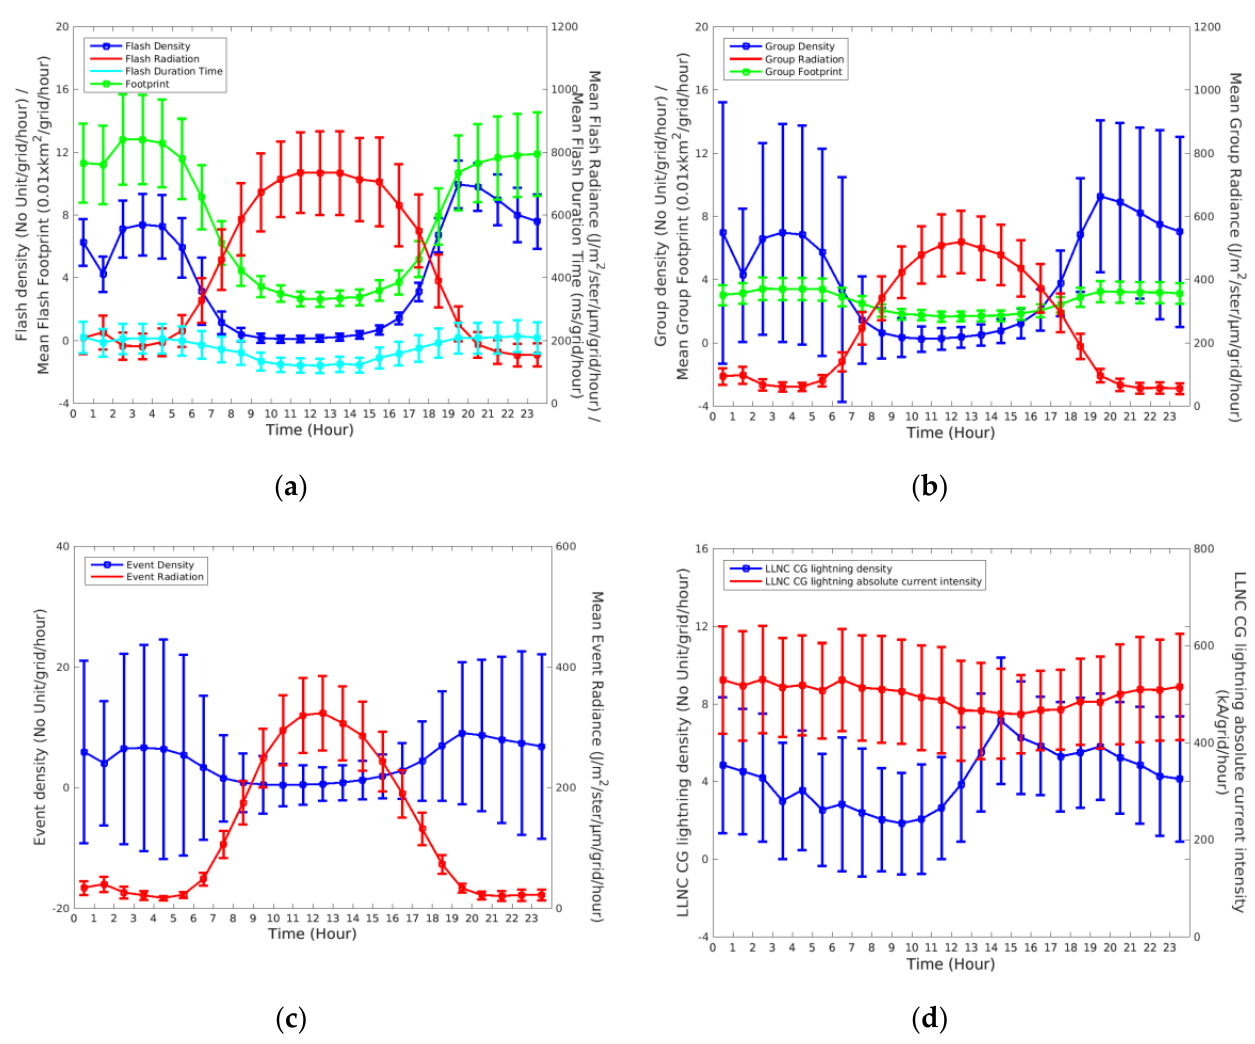
Figure 12. Hourly variation in the LMI Flashes, Groups, and Events, and the LLNC flashes in China. ( a ) Flash, ( b ) Group, ( c ) Event, and ( d ) LLNC CG Event. The time is UTC (Coordinated Universal Time).